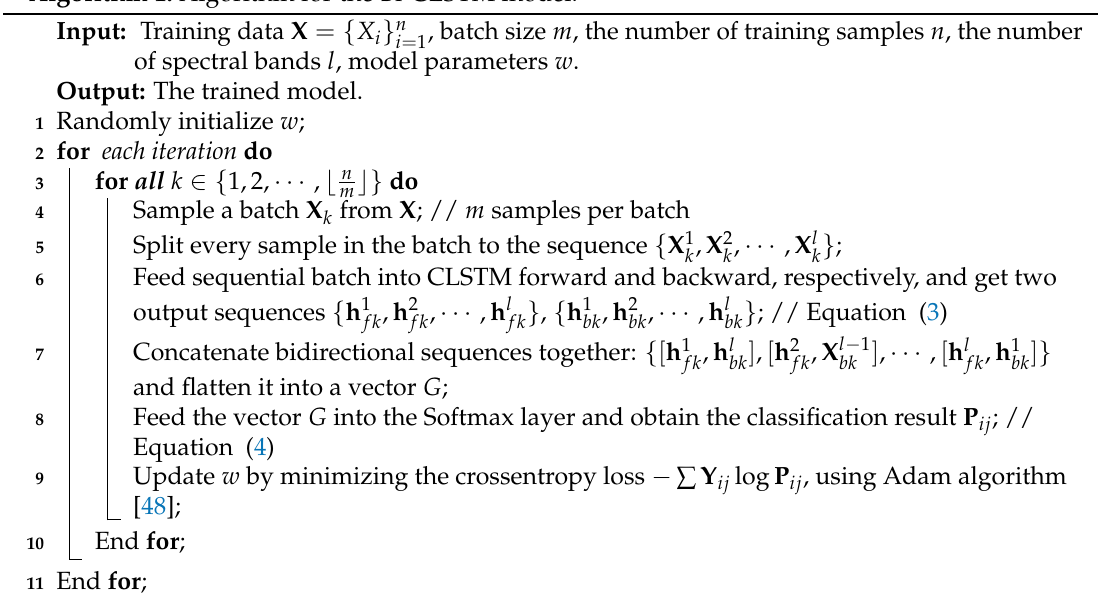
Algorithm 1: Algorithm for the Bi-CLSTM